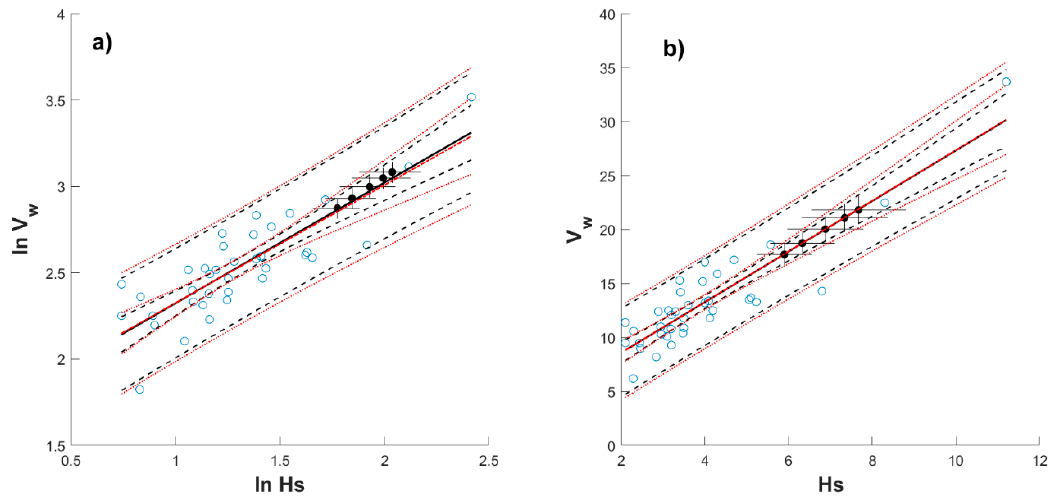
Figure 7. Regression lines and confidence intervals including (solid and dashed lines, respectively) and excluding (dashed–dotted and dotted lines, respectively) T -yr values for October; ( a ) and ( b ) for logarithmic space and linear space, respectively. Filled circles are given by T -yr values with embedded perpendicular lines indicating confidence intervals from GEV models.